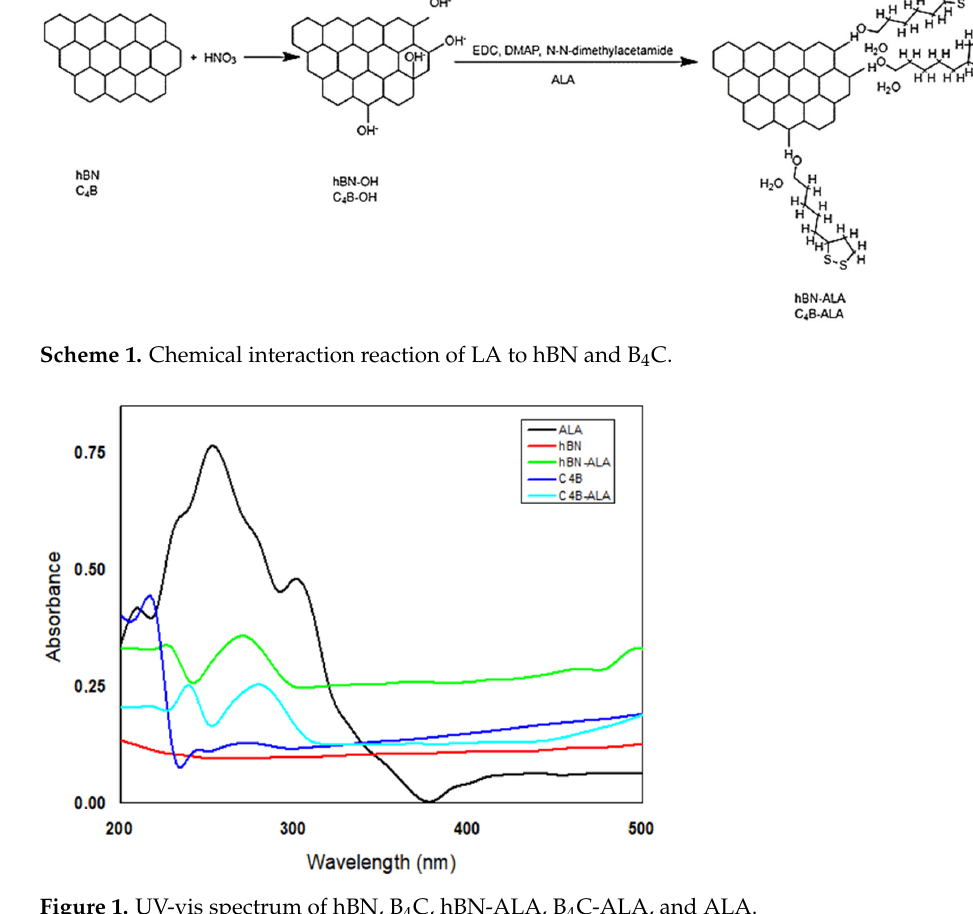
Figure 2. Images ( A ) hBN, ( B ) hBN ‐ ALA ( C ) B 4 C, and ( D ) B 4 C ‐ ALA at 100 nm scale under TEM.